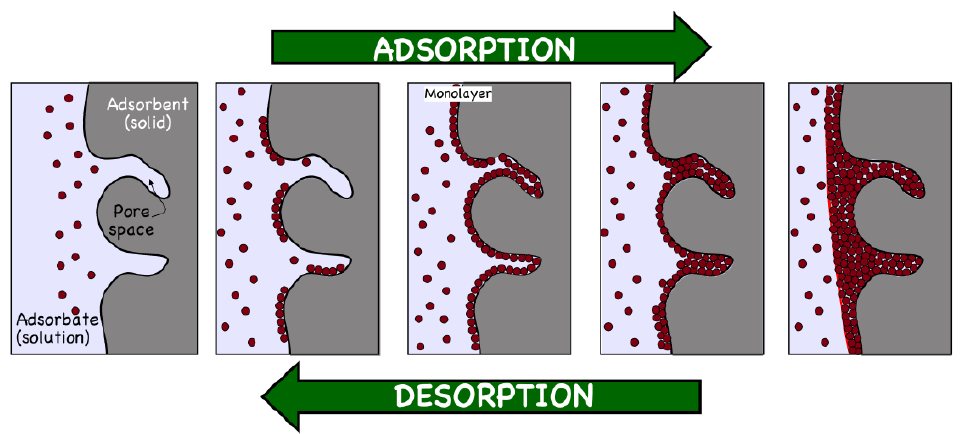
Figure 6. Simplified diagram of the adsorption process (adapted from [58 – 60]). Atoms, molecules or ions adhere to a surface by weak residual forces (e.g., van der Waals, electrostatic). It can be multilayer or monolayer. (This figure is an original interpretation by L. Pomar based on several sources).